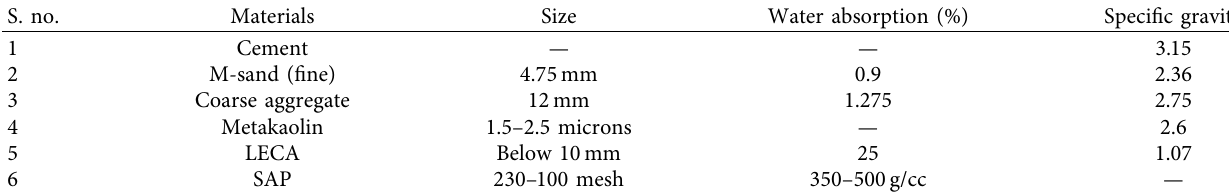
Table 2: Material characteristics.